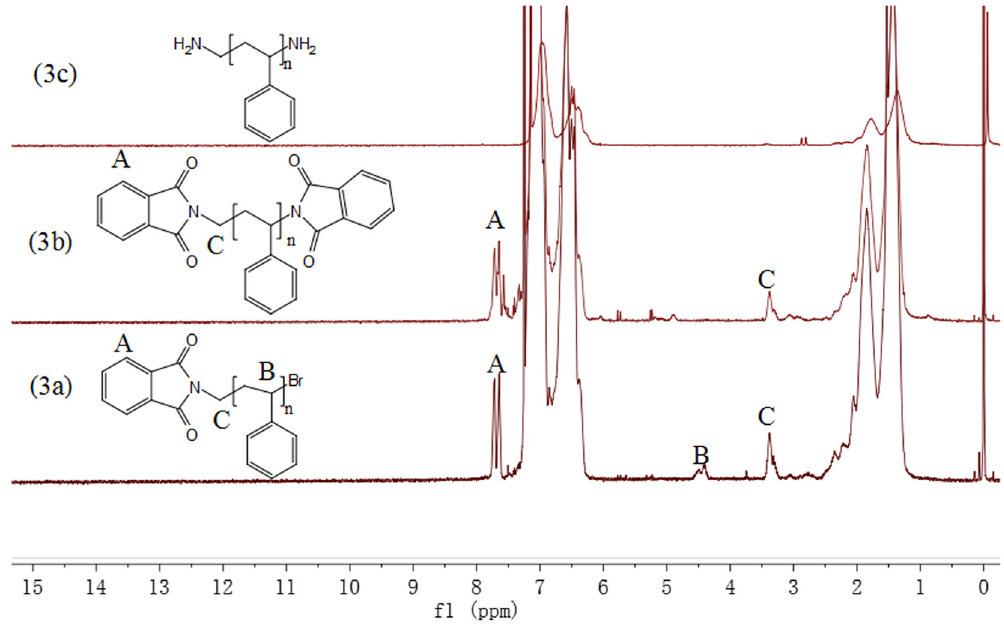
Figure 2: 1 H NMR spectra of 3a , 3b and 3c ; A: Ar – H , B: Ph – C H – Br, C: phthalimide – C H 2